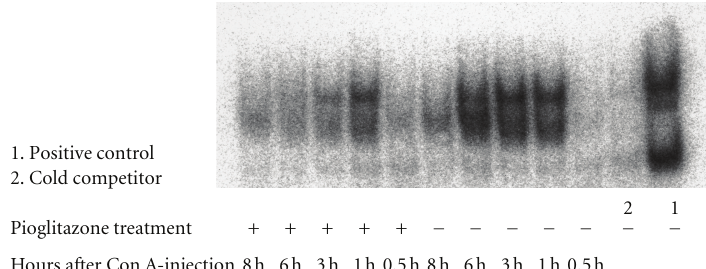
Figure 5: NF- κ B binding was determined by EMSA. We collected liver tissue specimens at various time points (0.5, 1, 3, 6, and 8h) after Con A injection. At 1h after the Con A injection, NF- κ B was activated in the nonpioglitazone-treated mice, whereas the NF- κ B activation was suppressed in the pioglitazone-treated